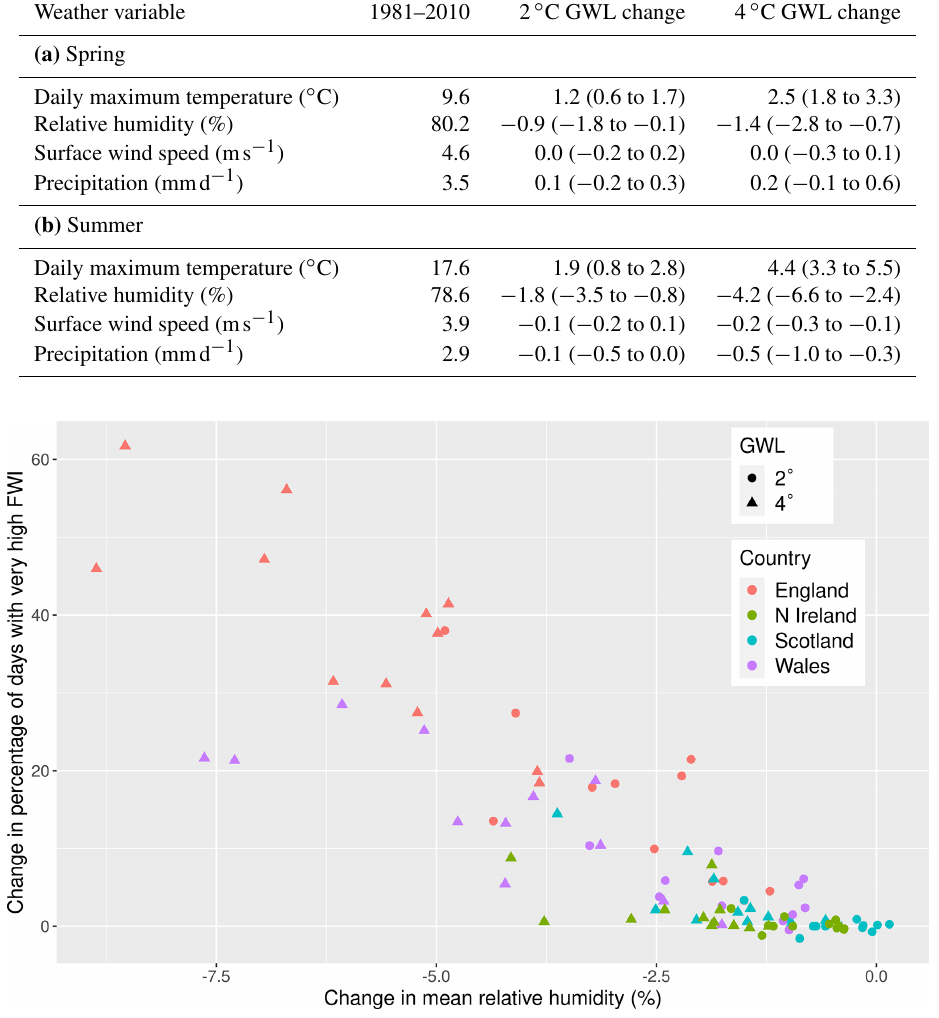
Figure 11. Scatter plot of change in the percentage of summer days with very high FWI against change in mean relative humidity (%), by country and ensemble member. Changes are from 1981–2010 to the 2 and 4 ◦ C global warming